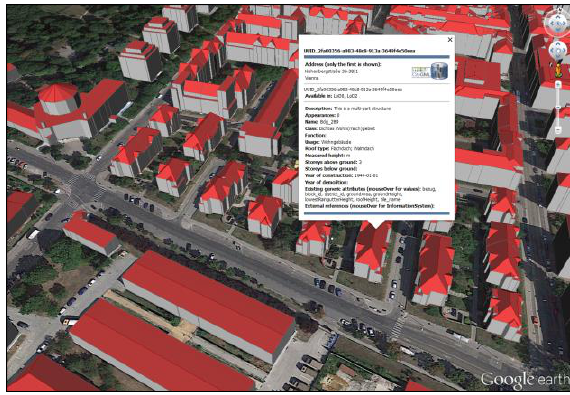
Figure 6. Example of the resulting 3D city model, visualised in Google Earth